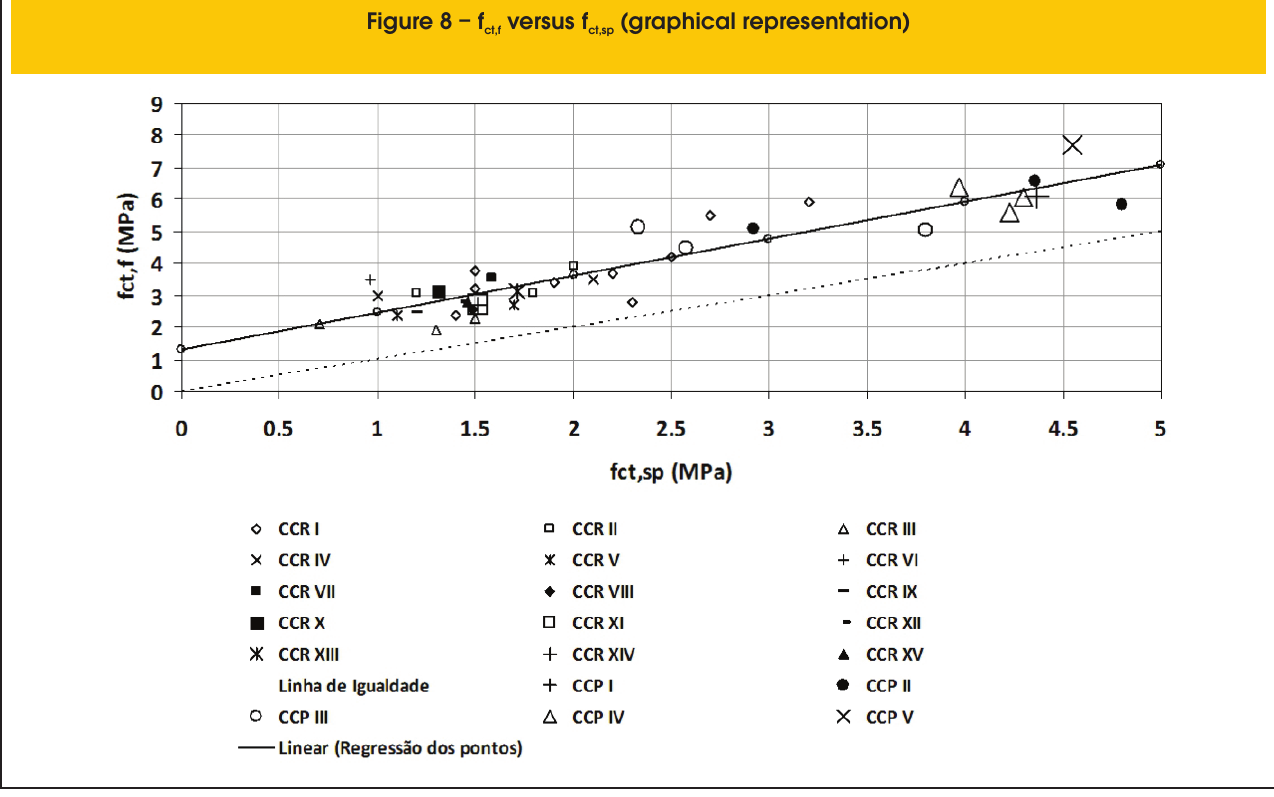
Figure 8 – f versus f (graphical representation)